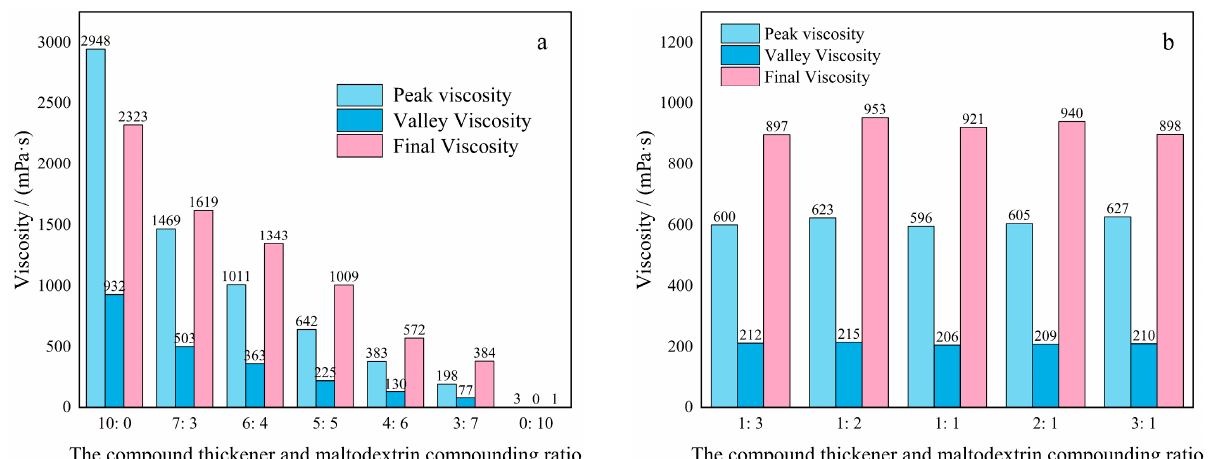
Figure 9. Viscosity changes in compound thickeners and maltodextrin in different proportions: ( a ) the total concentration of mixed solution at 10.0 mg/mL; ( b ) the concentration of compound thickener at 5.0 mg/mL.